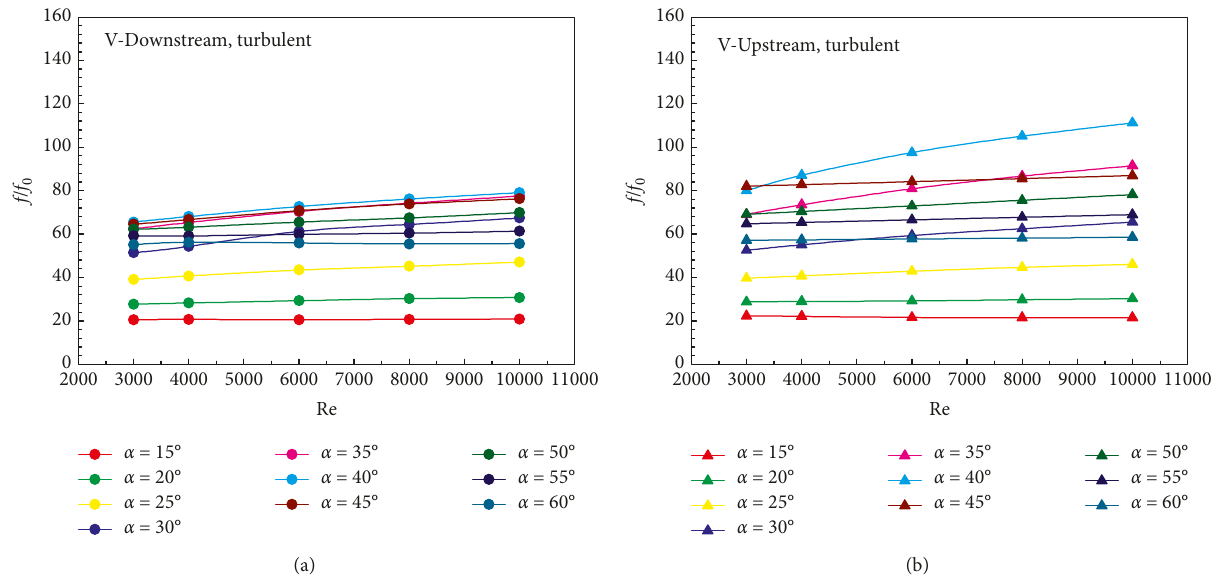
Figure 22: Relations of f / f 0 with Re for the heat exchanger tube inserted with the V-wavy surface for (a) V-Downstream and (b) V-Upstream at the turbulent regime.